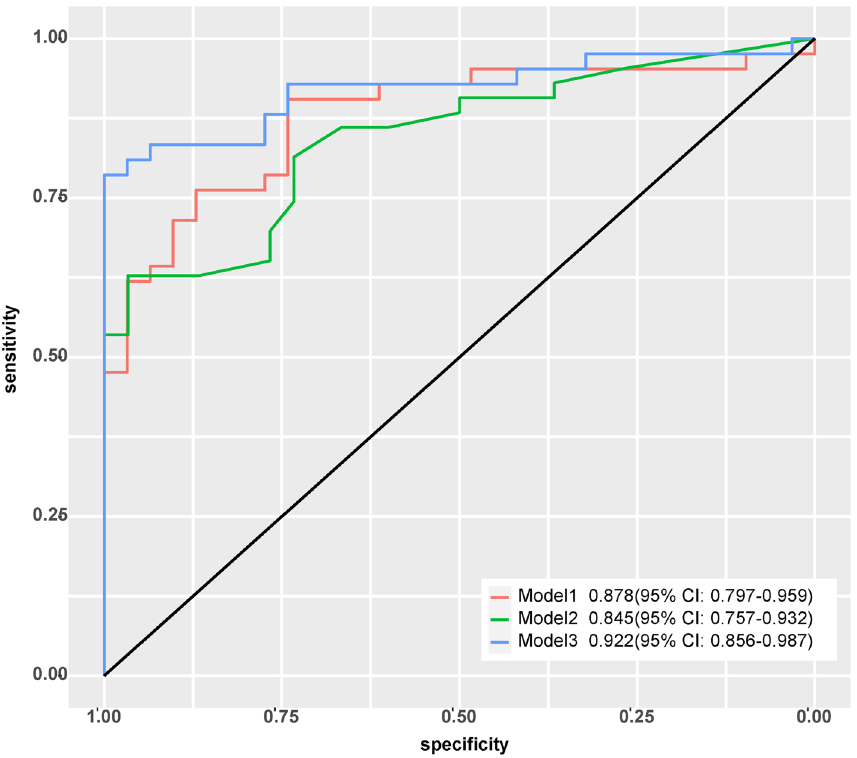
Figure 2. ROC curves of three